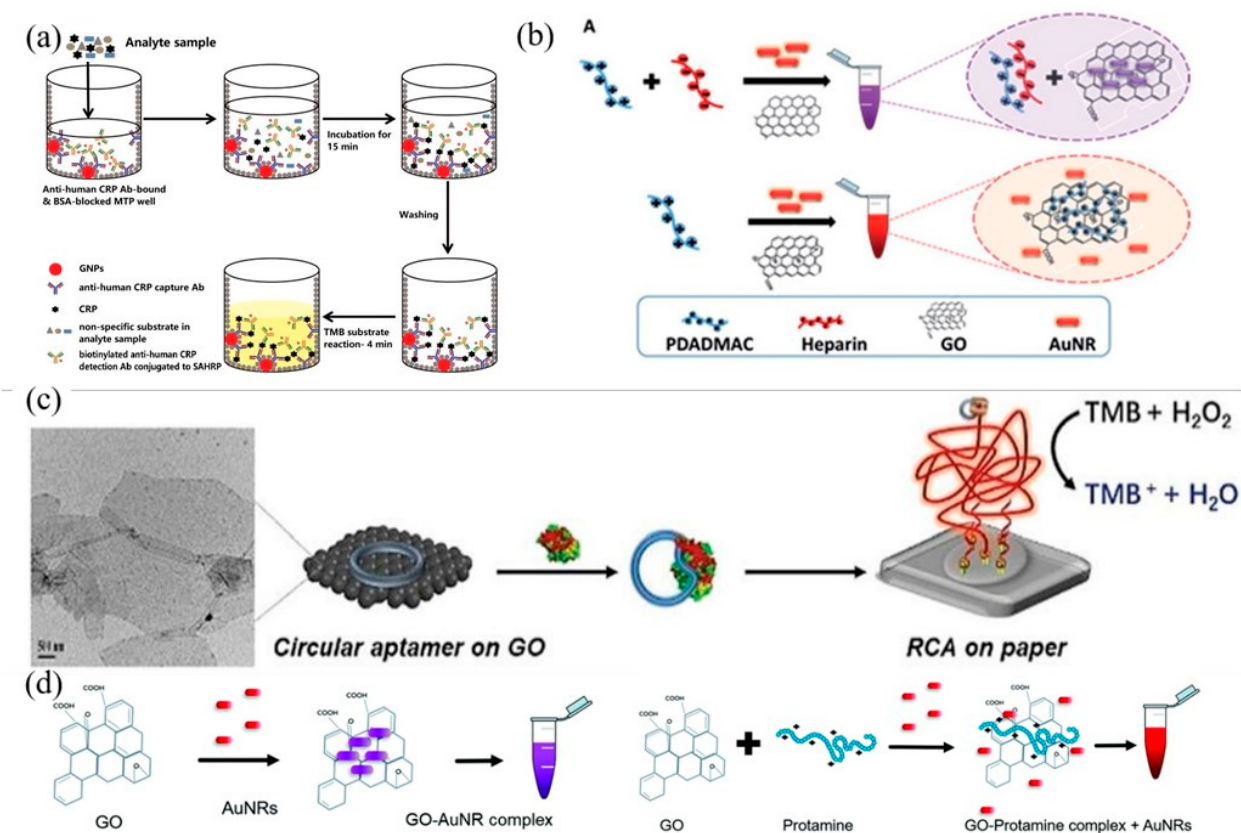
Figure 2. ( a ) GNP/MTP detection CPR. Reprinted with permission from Ref. [55], Copyright 2013, Elsevier. ( b ) PDADMAC is probe colorimetric detection of heparin. Reprinted with permission from Ref. [56], Copyright 2019, Royal Society of Chemistry. ( c ) Circular aptamer-modified graphene colorimetric detection of protein. Reprinted with permission from Ref. [57], Copyright 2019, Royal Society of Chemistry. ( d ) GO/AuNR hybrids for colorimetric detection of protamine. Reprinted with permission from Ref. [58], Copyright 2019, Royal Society of Chemistry.